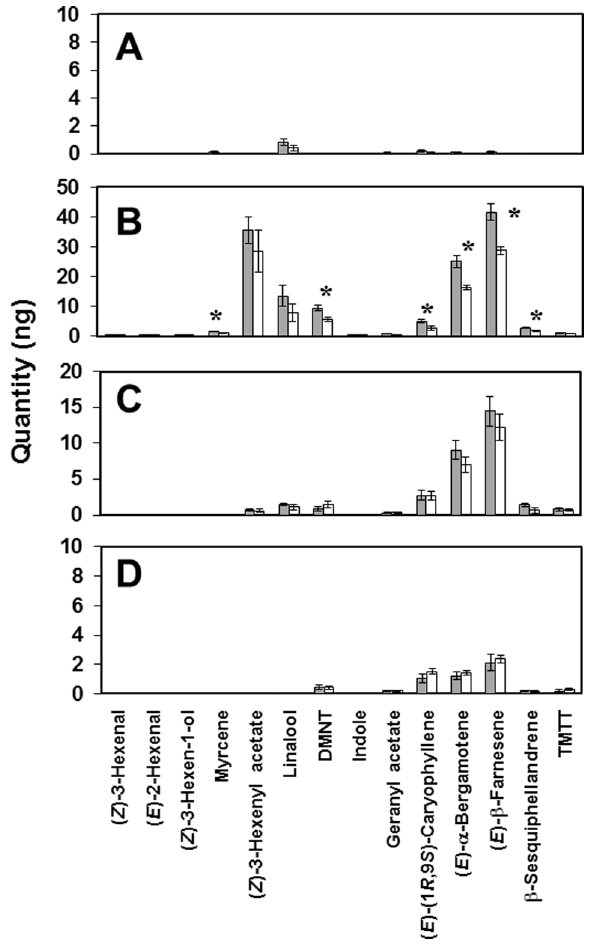
Figure 2. Mean quantities ( ± SE) of VOCs released by maize( Zea mays ) seedlings following either CJ or control treatment, and then wounding + JA exposure 24 h later. VOCs were collected every 24 h over a continuous 96 h period. A=24 h period between CJ or control treatment and wounding + JA exposure; B=0–24 h after wounding + JA exposure; C=24–48 h after woun- ding + JA exposure; D=48–72 h after wounding + JA exposure. ( E )-4,8- dimethyl-1,3,7-nonatriene=DMNT; ( E,E )-4,8,12-dimethyl-1,3,7,11-tride- catetraene=TMTT. Data were expressed as nanograms of VOC released per 24 h collection period (9 plants were used per treatment) and were analysed using paired t -tests * P , 0.05. n=4. Grey columns=CJ treatment, then wounding + JA. White columns=control treatment, then wounding + JA.